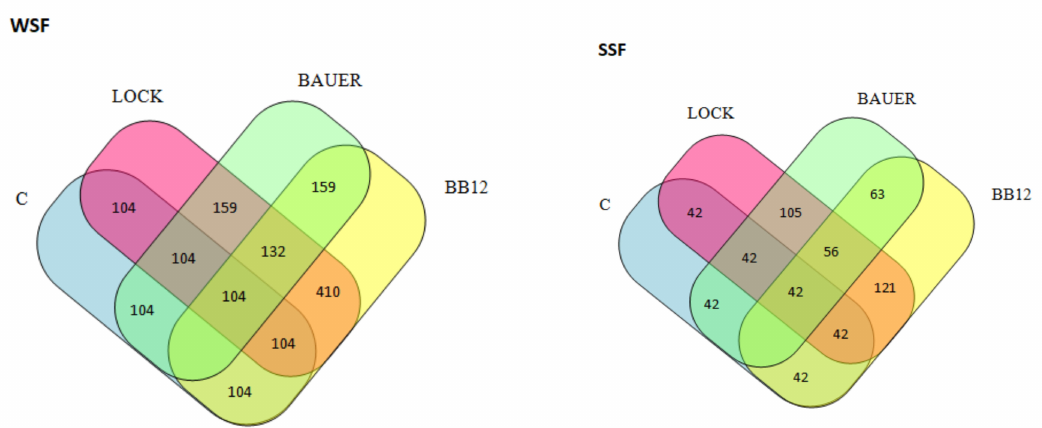
Figure 2. Correlation (Pearson’s correlation coefficient) between peptides content and DPP-IV- inhibiting activity of the tested samples. WSF, water-soluble fraction; SSF, salt-soluble fraction; C, control sample; LOCK, sample inoculated with Lactobacillus rhamnosus LOCK900; BAUER, sample inoculated with Lactobacillus acidophilus Bauer Ł0938; BB12, sample inoculated with Bifidobacterium animalis ssp. lactis BB-12.